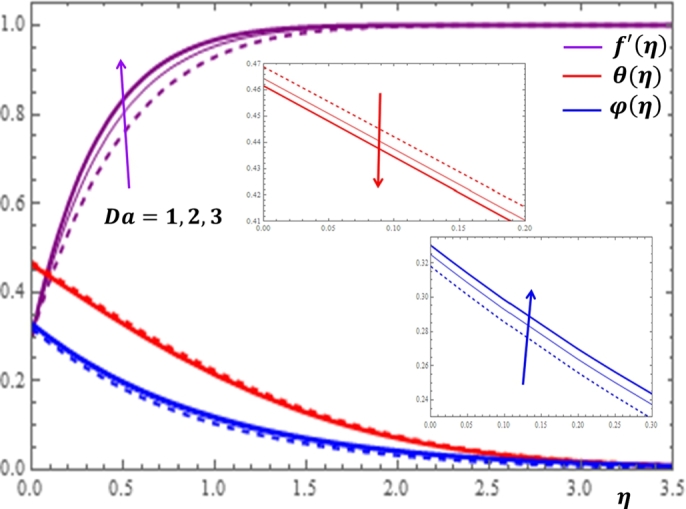
Impacts of Darcy number Da on f′(η), θ(η) and φ(η).